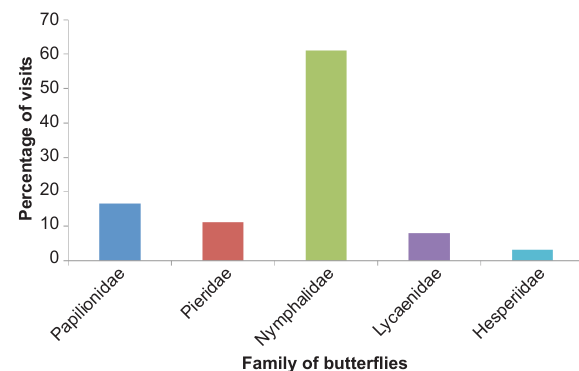
Figure 1. Family-wise number of butterfly species foraging for nectar on Chromolaena odorata